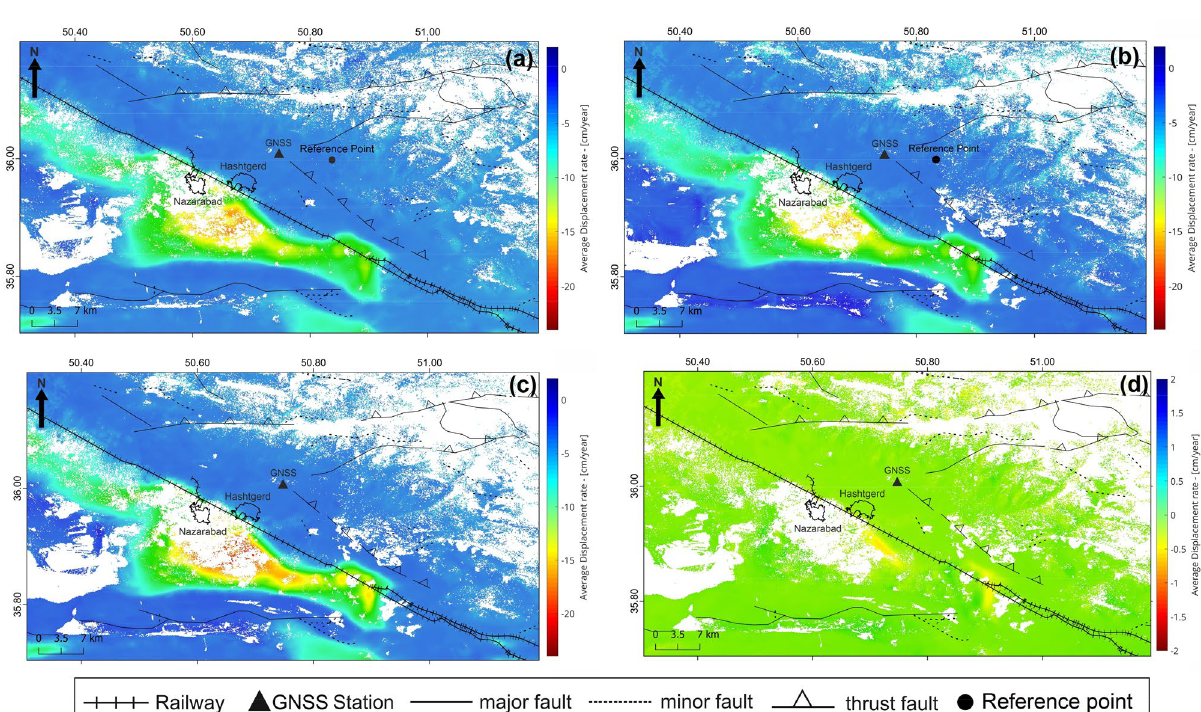
Figure 6. Map of ground surface displacement velocity in ( a ) ascending track ( b ) descending track west direction-displacement velocity in ( c ) vertical direction and ( d ) east. This figure was created using the